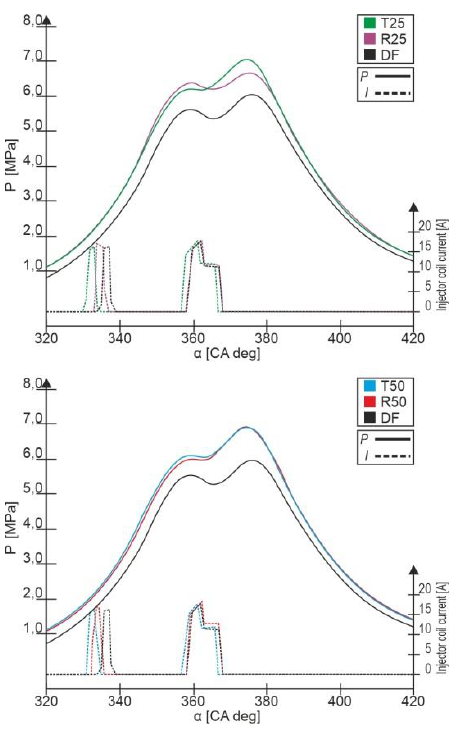
Fig. 4. In-cylinder pressure and injection current versus CA for 150 Nm load